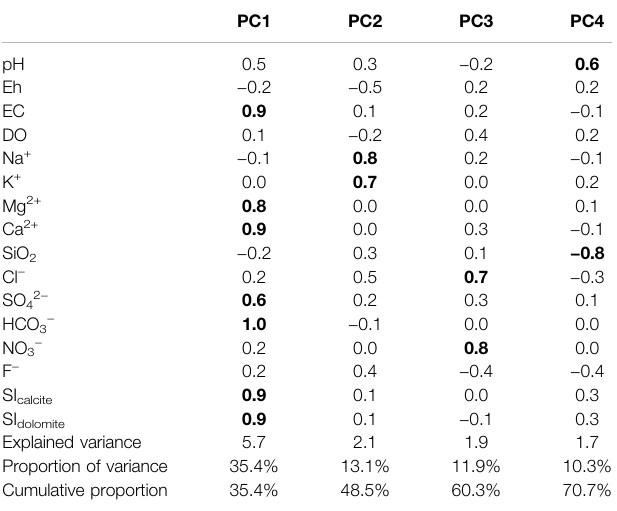
TABLE 2 | Loadings of principal components (PCs). Absolute values of loadings ≥ 0.6 are in